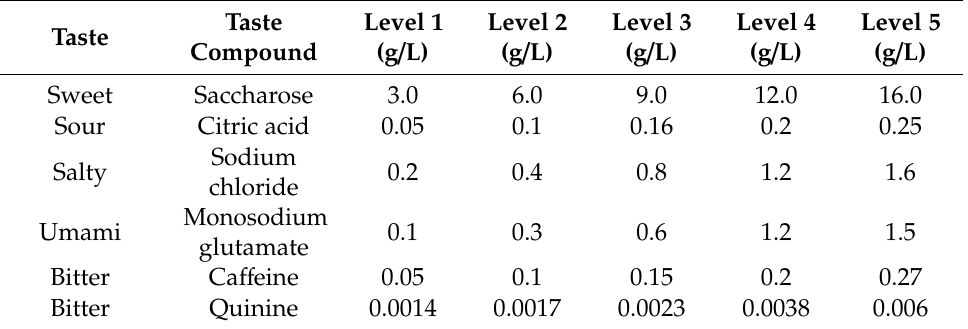
Table 1. Basic taste concentration